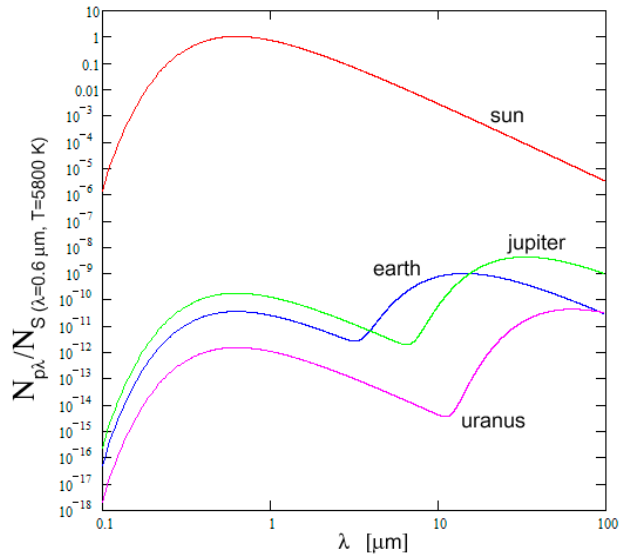
Figure 1. Normalized number of spectral photons, emitted per unit time and area by Sun and various planets at 10 parsec from our solar system, vs wavelength